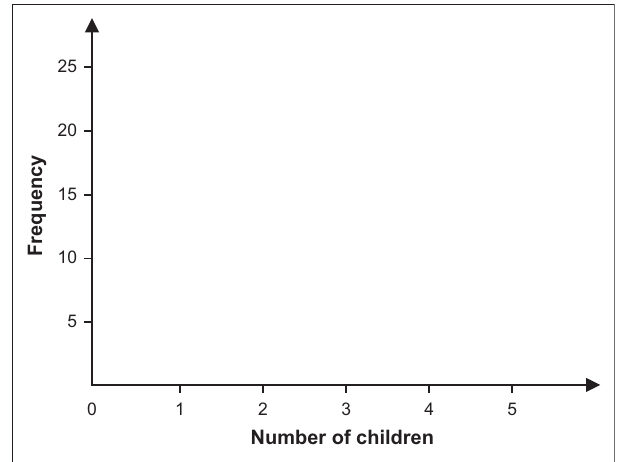
FIGURE 7: Axes drawn for the bar graph.